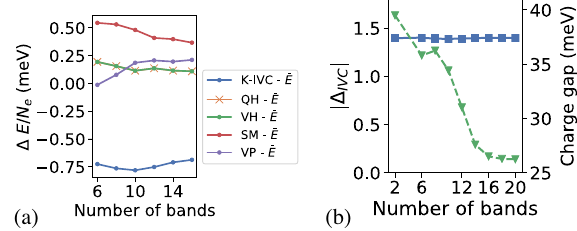
FIG. 3. (a) Energies per electron in the flat bands of the K-IVC, QH, VH, SM, and VP states relative to the average energy of the ¯ E K-IVC,QH,VH,andSM(denotedas ),asafunctionofthenumber of bands per spin and valley kept in the Hartree-Fock numerics. P k Þ 2 Þ 1 = 2 =N (b) IVC order parameter j Δ tr ð P , where M IVC j ¼ IVC ð k k Þ is the U 1 Þ -breaking part of P ð k Þ and N P the number of V ð M IVC ð moir´e unit cells (left, blue squares). We show the charge gap (right, green triangles) at charge neutrality as a function of the number of bands per spin and valley. The results in both panels (a) and (b) were obtained on a 12 × 12 momentum grid with θ ¼ 1 . 05 °, w 0 ¼ 80 meV, w 1 ¼ 110 meV, and ϵ ¼ 7 . Note that the energies of the VH and QH states are numerically